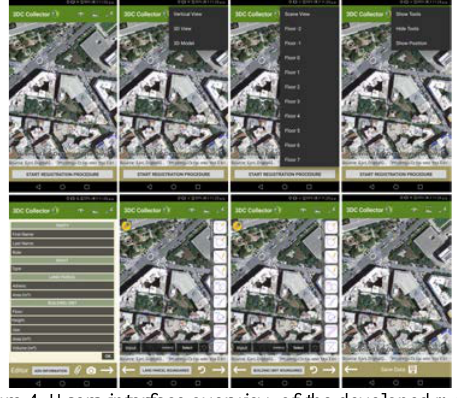
Figure 4. Users interface overview of the developed mobile application (Figure 5): two (2) circle drawing tools; two (2) line segment drawing tool; a parallel lines drawing tool, at a certain distance from a specific line (full offset); a drawing tool of vertical lines of certain length on either side of a specific line; and, three tools for determining intersection points between 2 circles, a